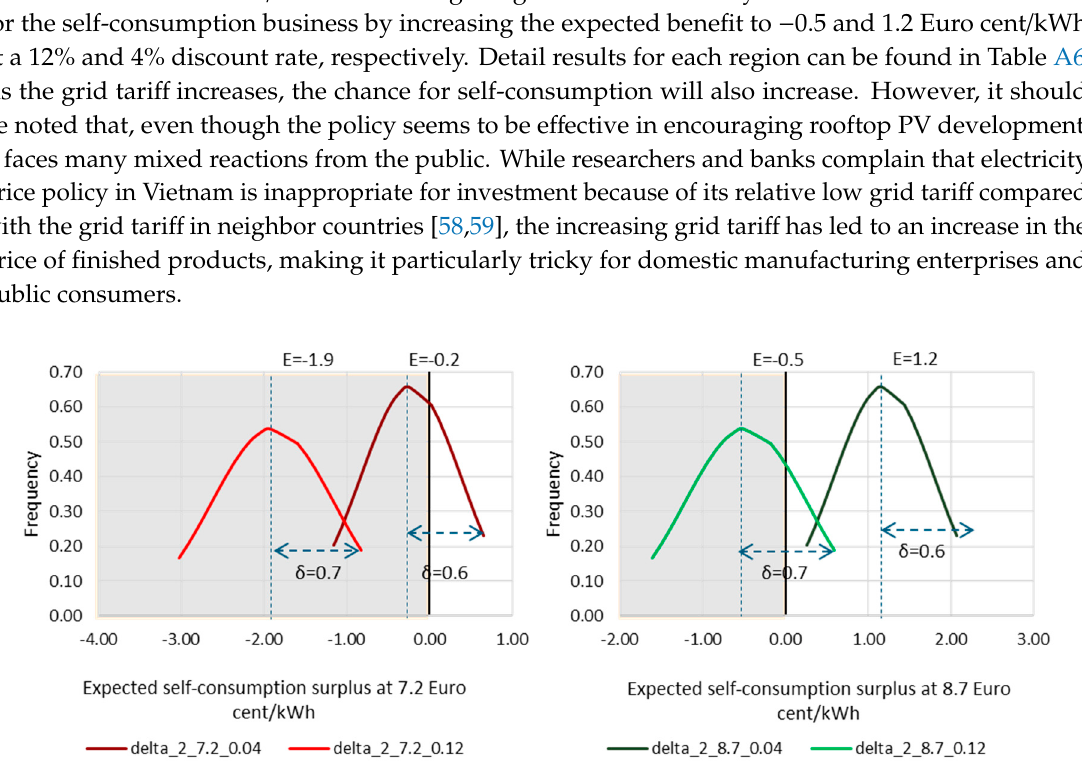
( b ) Figure 15. Expected business market ( a ) and expected self-consumption ( b ) surplus change in accordance with investment costs increase from 635 to 1038 Euros/kWp. 5.4. Critical Discussion